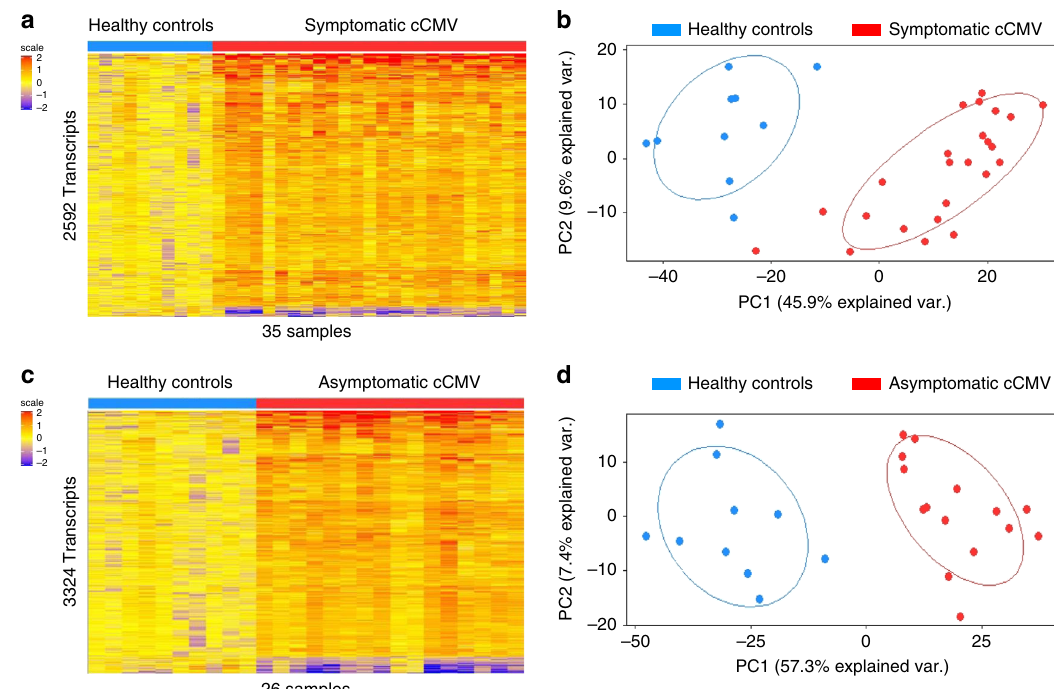
Fig. 1 Biosignatures for symptomatic and asymptomatic cCMV infection. a Statistical group comparisons using linear models (LIMA) adjusted for age followed by Benjamini – Hochberg FDR < 0.01 and ≥ 1.5 fold change between infants with symptomatic cCMV infection ( n = 25) and healthy controls ( n = 10) identi fi ed 2592 differentially expressed transcripts in the training set (symptomatic cCMV biosignature). b The transcriptional signature was validated by principal component analyses (PCA) in an independent test set of 24 infants with symptomatic cCMV and the same 10 healthy controls. Healthy controls are represented in blue and symptomatic cCMV patients in red. c A similar strategy was applied to derive and validate the asymptomatic cCMV biosignature using 16 cCMV infants in the training set and 10 healthy controls, which yielded 3324 differentially expressed genes. d The asymptomatic cCMV biosignature was validated by PCA in an independent test set of 15 infants with asymptomatic cCMV infection and the same healthy controls. Transcripts in a and c are organized in a heatmap format where each row represents a transcript and each column a patient sample. Red color indicates overexpression and blue color underexpression of a transcript compared with the median expression of healthy controls